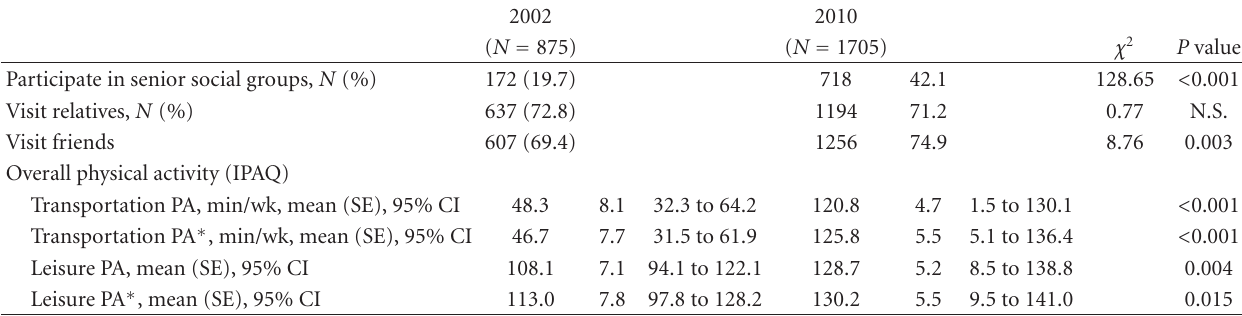
Table 4: Time spent in physical activity (leisure transportation and total) among older adults participating in “ convivˆencia ” groups, in 2002 and